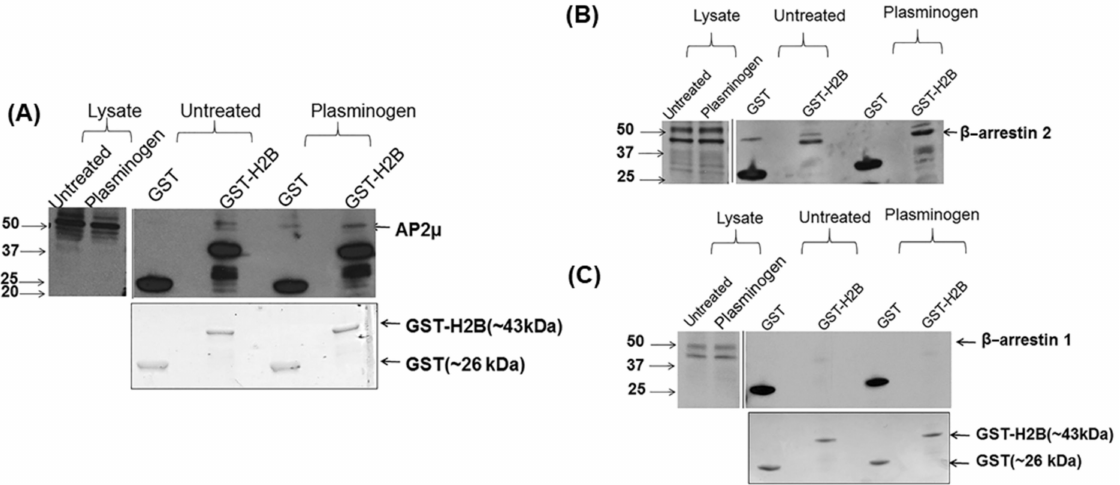
Figure 5. Association of H2B with clathrin adaptor AP2 µ and β -arrestin 2 in HUVECs. In pulldown assays, GST-H2B substantially interacted with ( A ) clathrin adaptor AP2 µ and ( B ) β -arrestin 2, in Plg- treated HUVECs compared to unstimulated HUVECs. ( C ) GST-H2B did not interact with β -arrestin 1 under these conditions. Loading of GST and GST-H2B is shown via Coomassie stained gels. “Lysate” denotes lysates of untreated or Plg-treated HUVECs. Mouse anti-AP2 µ , mouse anti- β -arrestin 2 and mouse anti- β -arrestin 1 antibodies detected these proteins in immunoblots. Solid lines between gels denote the position of the molecular weight ladder and the molecular weight markers are indicated in